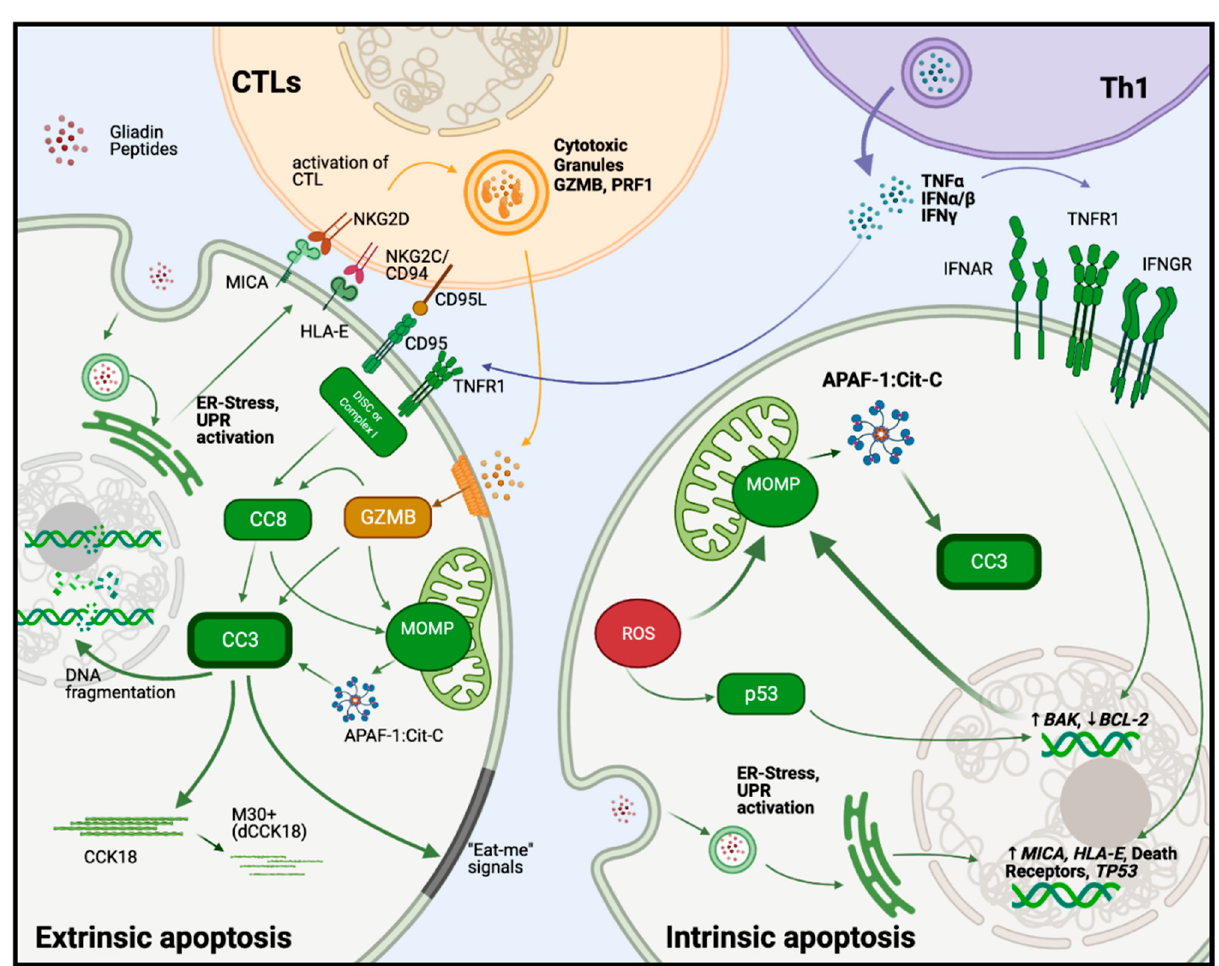
Figure 1. Extrinsic and intrinsic mechanisms of apoptosis playing a role in celiac disease mucosae. On the left side of the picture, there is the scheme of the extrinsic apoptosis mechanism triggered by a CTL. As shown in the picture, in the celiac disease mucosae, the CTLs could trigger apoptosis directly by recognizing stressed ‐ related membrane proteins (MICA, HLA ‐ E) with specific NK receptors (NKG2D, CD94:NKG2C). This event promotes the degranulation of CTLs which re ‐ lease Granzyme B (GZMB) and Perforin ‐ 1 (PRF1) in the extracellular medium. PRF1 leads to GZMB entry into the